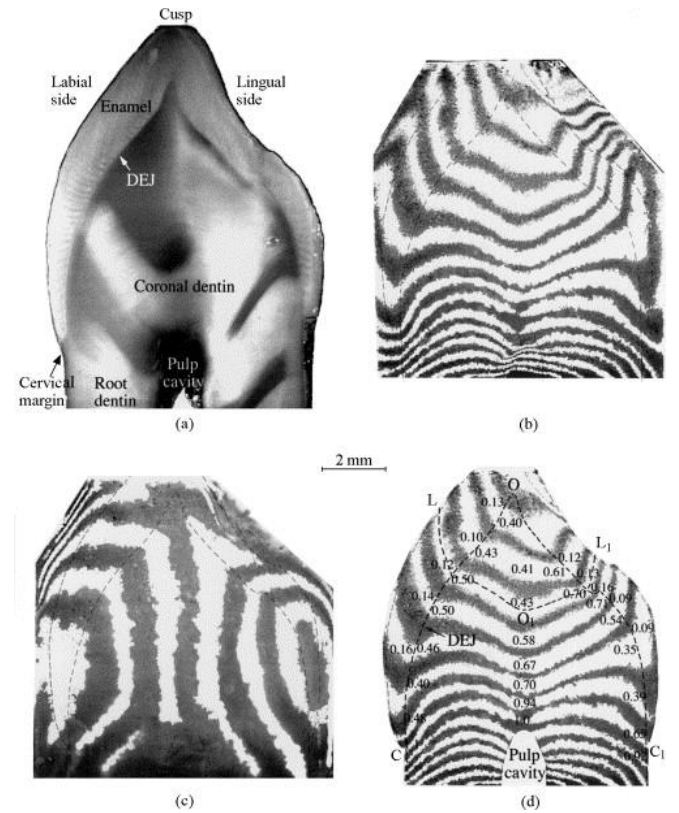
Figure 10. Canine tooth slice showing ( a ) anatomical terminology and ( b – d ) moiré fringe patterns obtained with a load of 500 N. Strain–structure relations in human teeth using moiré fringes. Adapted with permission from Ref. [106]. 2019, Elsevier.